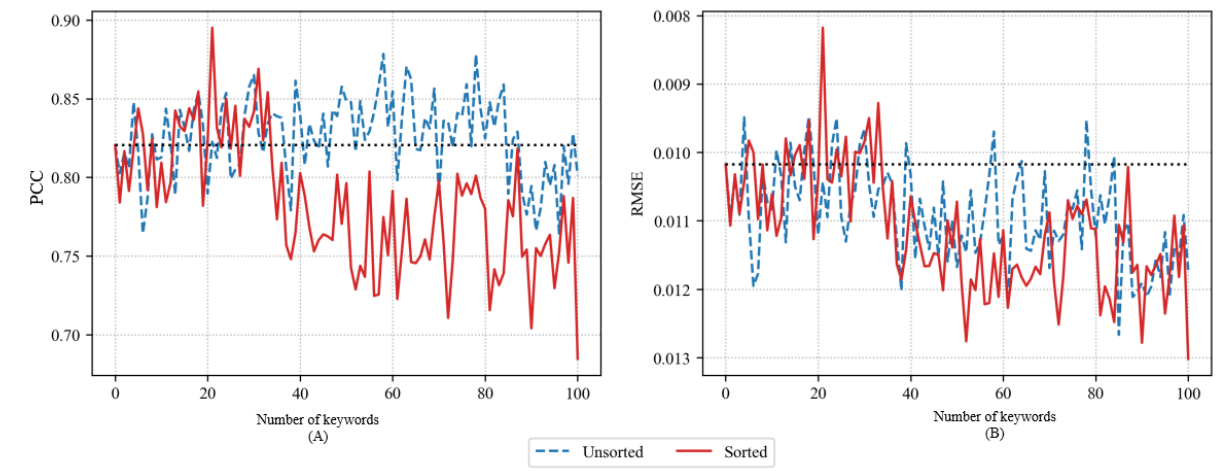
Figure 2. Pearson correlation coefficient (PCC) (A) and root-mean-square error (RMSE) (B) of long short-term memory models using Word2Vec continuous bag-of-words.